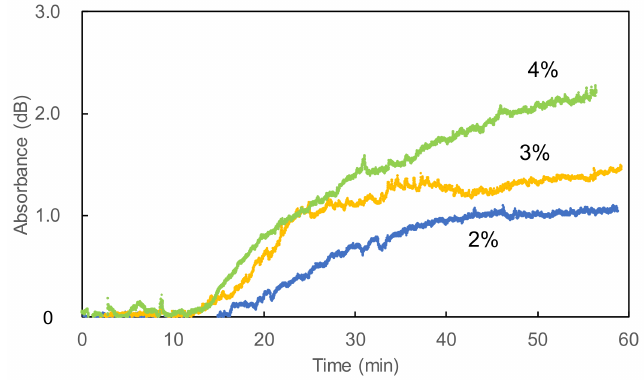
Figure 8. Temporal responses of CO 2 concentrations in a sample bag measured using the optical fiber probe. The injection of CO 2 gas was started at 10 min.